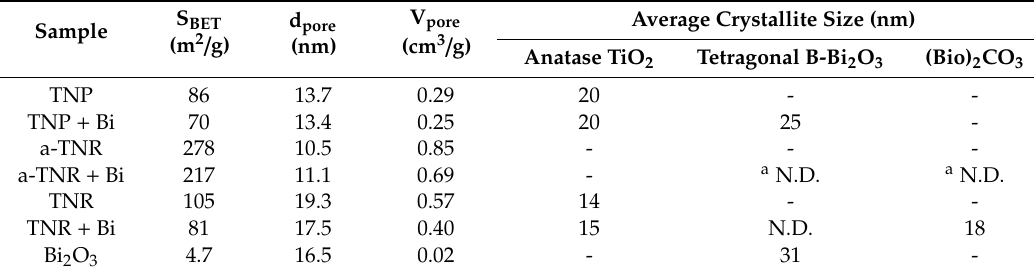
Table 1. Brunauer, Emmett and Teller theory (BET) specific surface area (S BET ), average pore diameter (d pore ), total pore volume (V pore ), and average crystallite size of (BiO) 2 CO 3 (JCPDS 00-041-1488), anatase